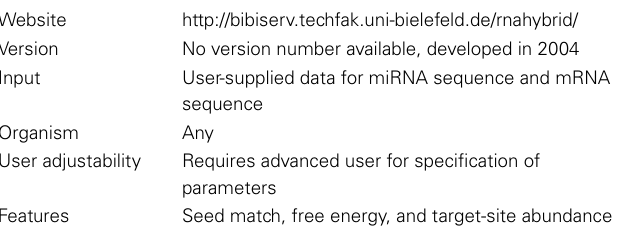
Table 10 | Profile of